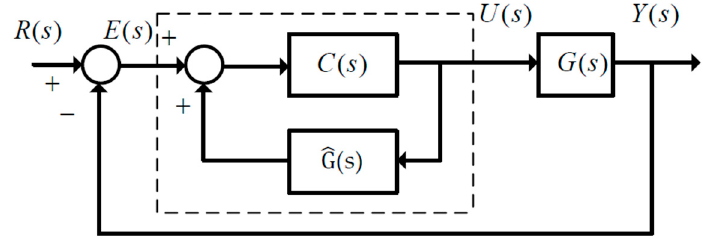
Figure 3. Internal model control.